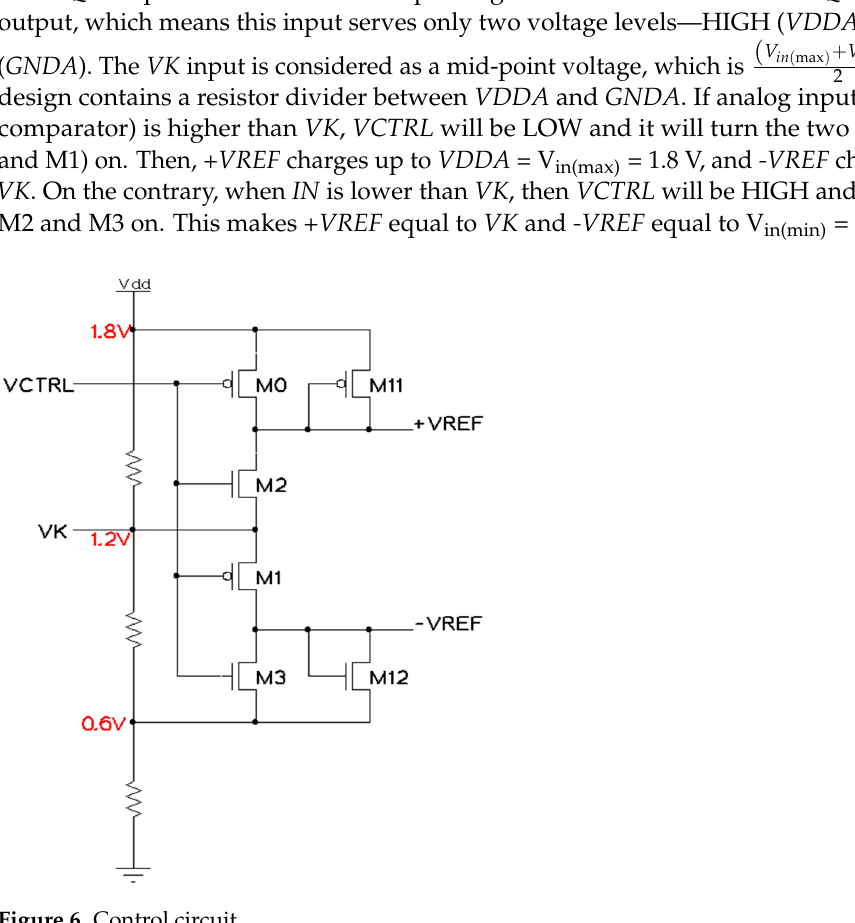
Figure 6. Control